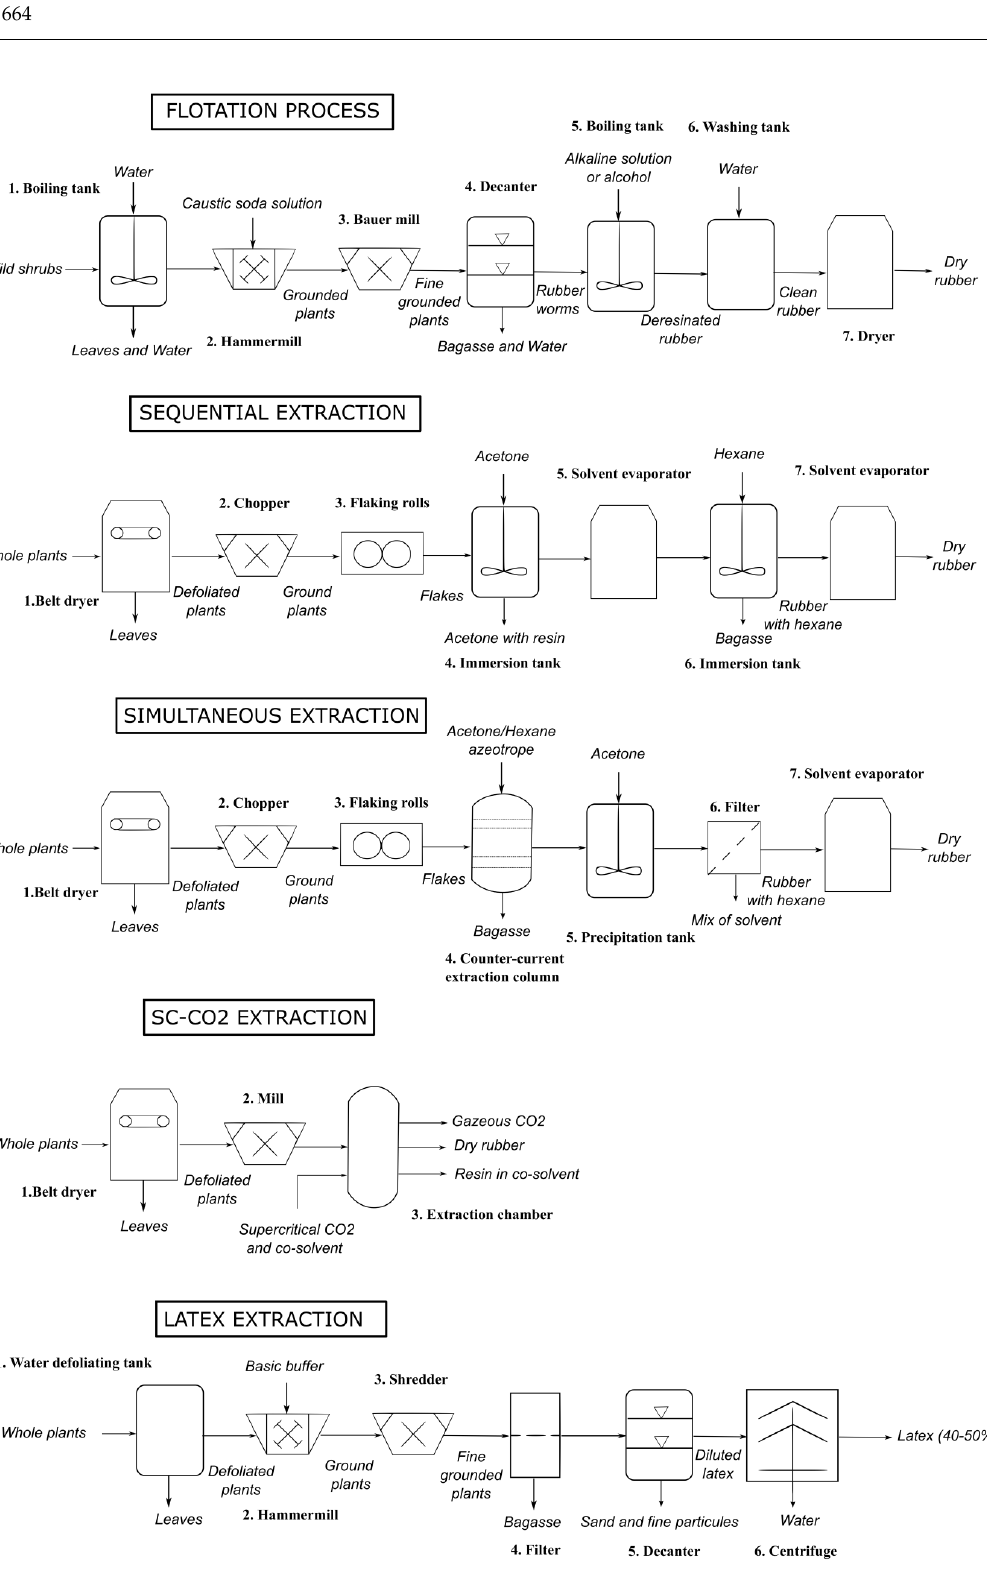
Figure 10. P&ID schemes of proposed industrial processes.